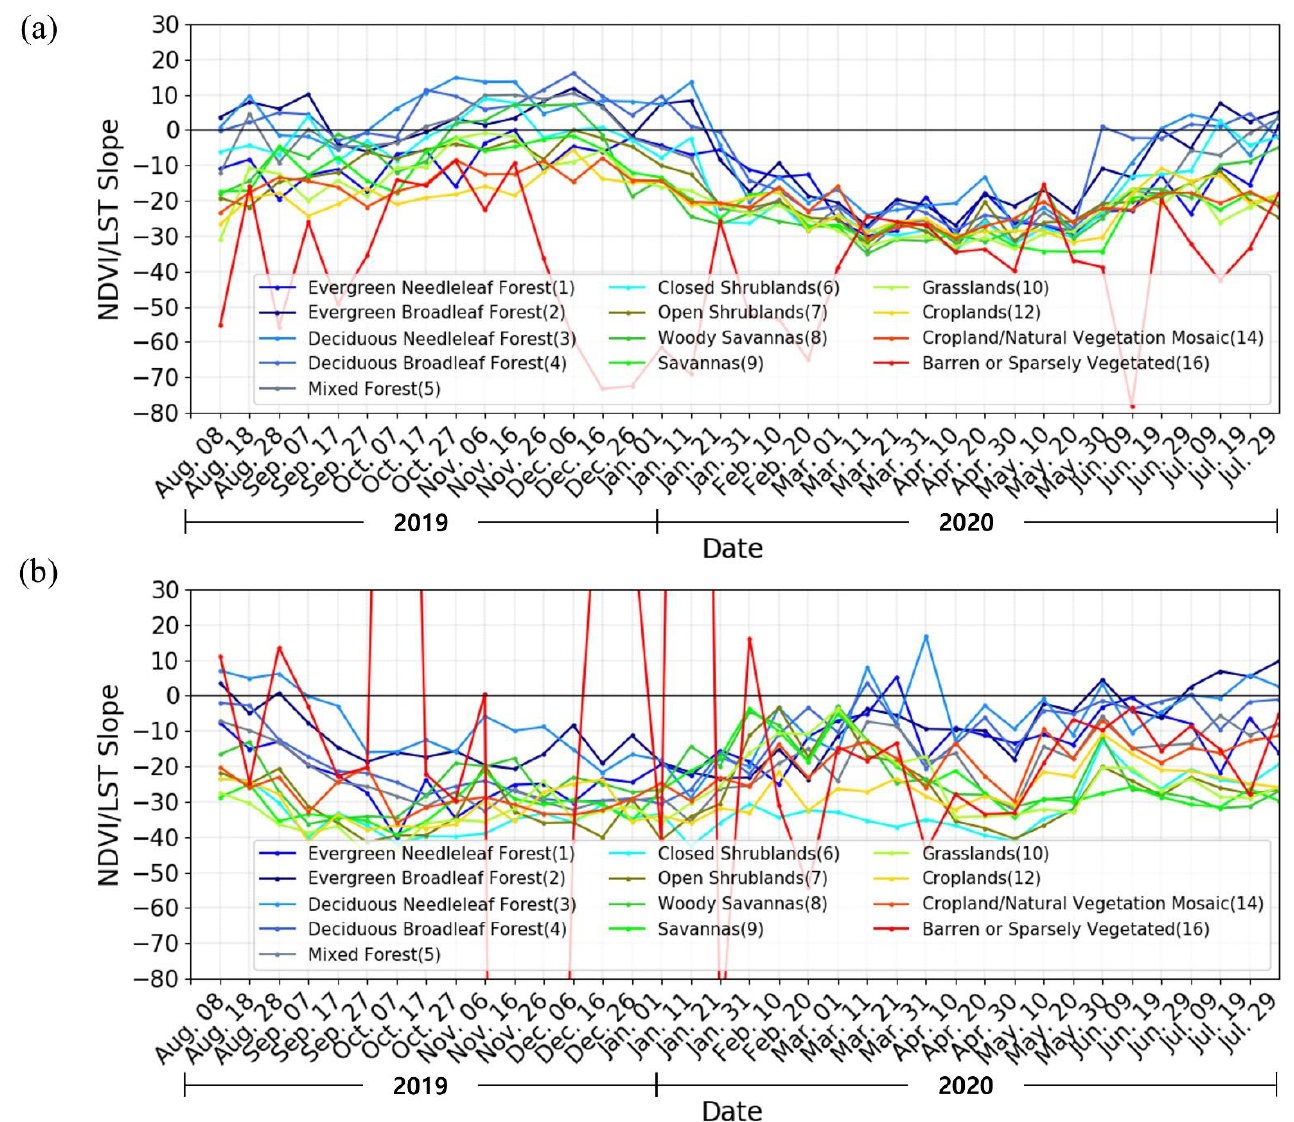
Figure 6. Time series of the slopes of the NDVI / LST space in ( a ) East Asia and ( b ) Australia from August 2019 to July 2020.